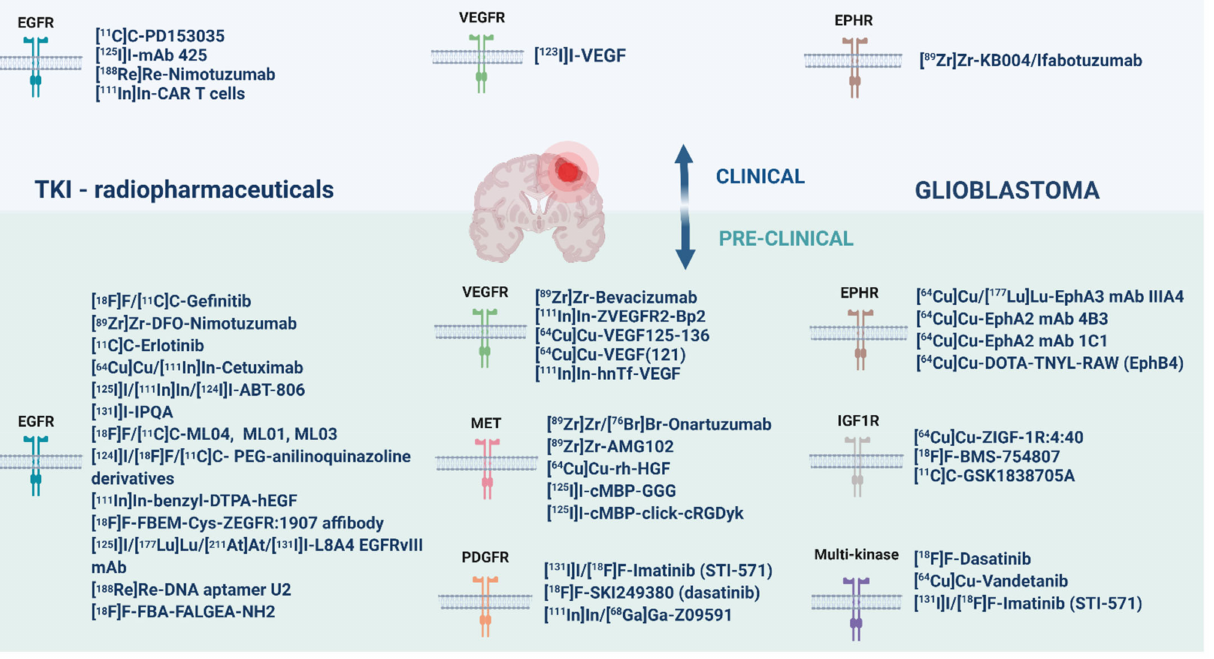
Figure 2. Overview of RTKI radiopharmaceuticals in GB. Info on organic radionuclides and radiometals commonly used for nuclear imaging and therapy purposes can be found in Tables 1 and